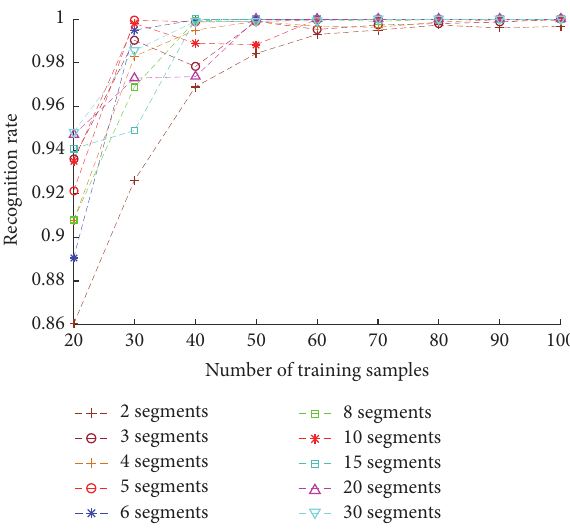
Figure 5: Comparison of recognition rates with different segment